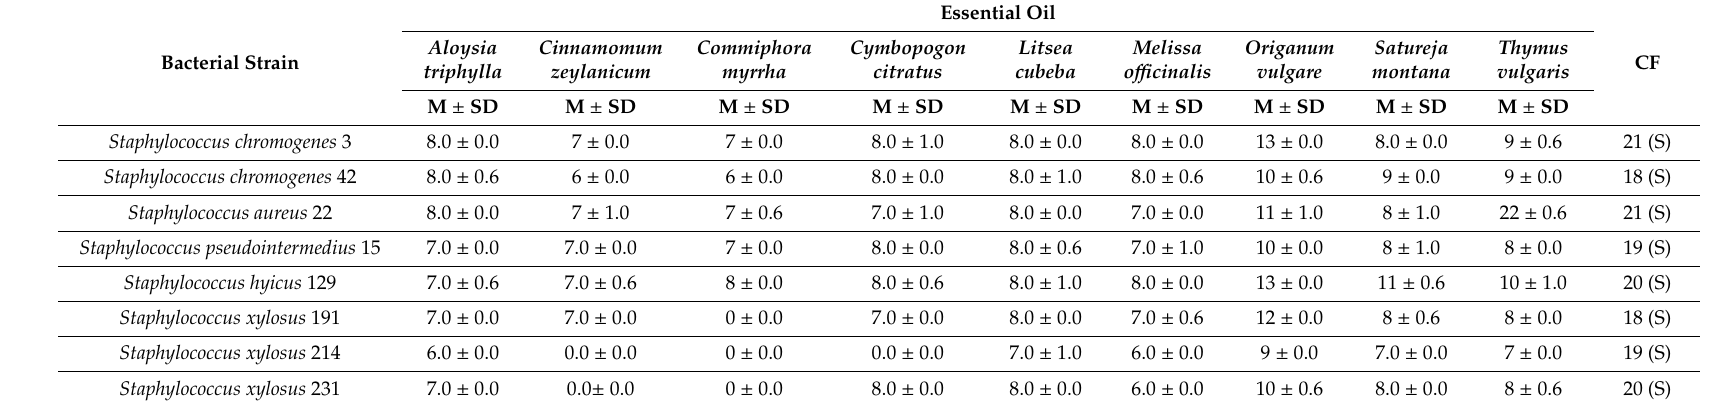
Table 2. The growth inhibition zones (expressed in mm) obtained testing the selected Staphylococcus isolates against the assayed EOs.